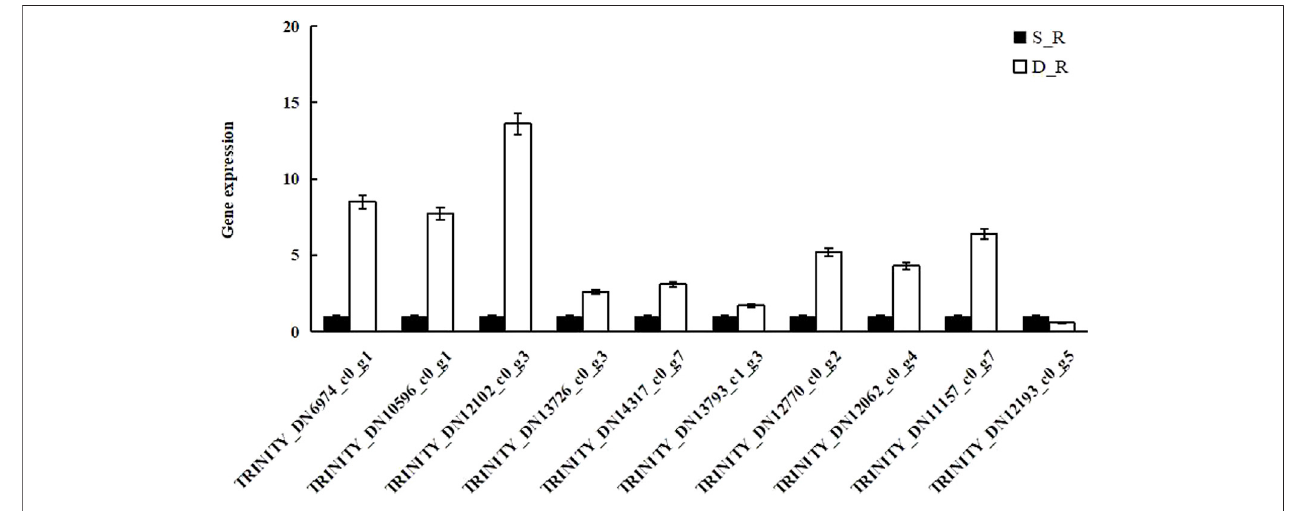
FIGURE 10 | The results of transcriptome data veri fi cation.